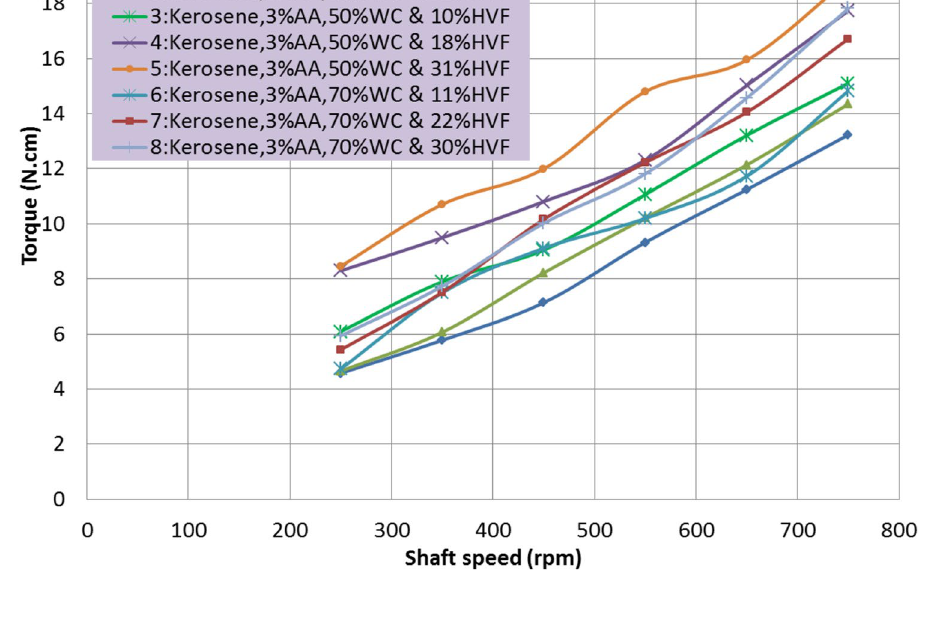
Fig. 14 In situ viscosity of hydrate slurries formed from kerosene–water systems. AA anti-agglomerant, WC watercut, HVF hydrate volume